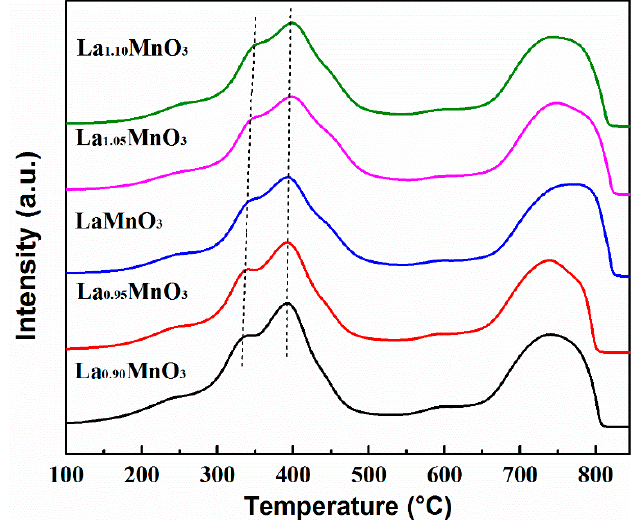
Figure 3. H 2 -TPR profiles of La x MnO 3 catalysts.